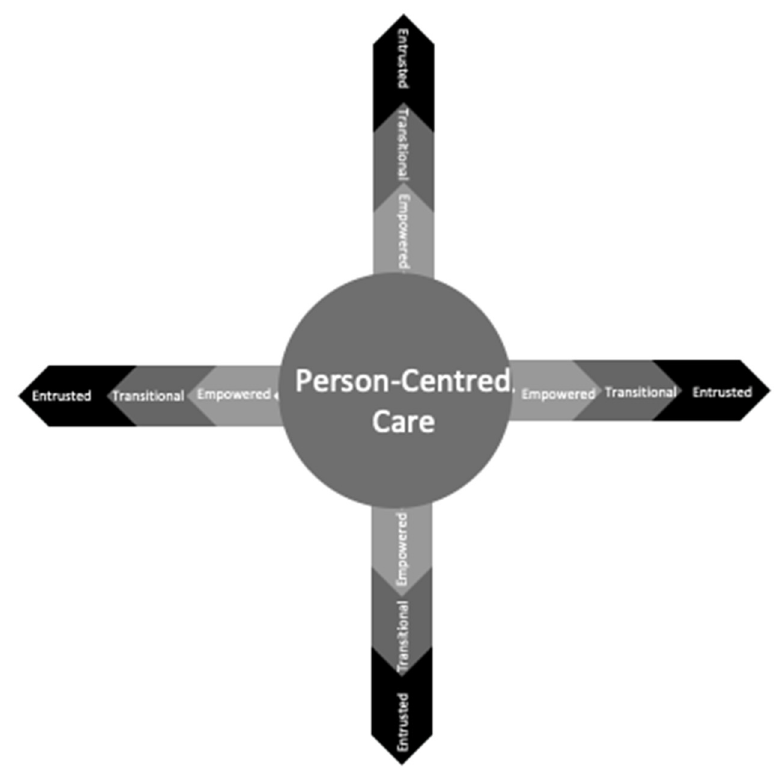
Figure 4. Layer 3, Capability continuum.